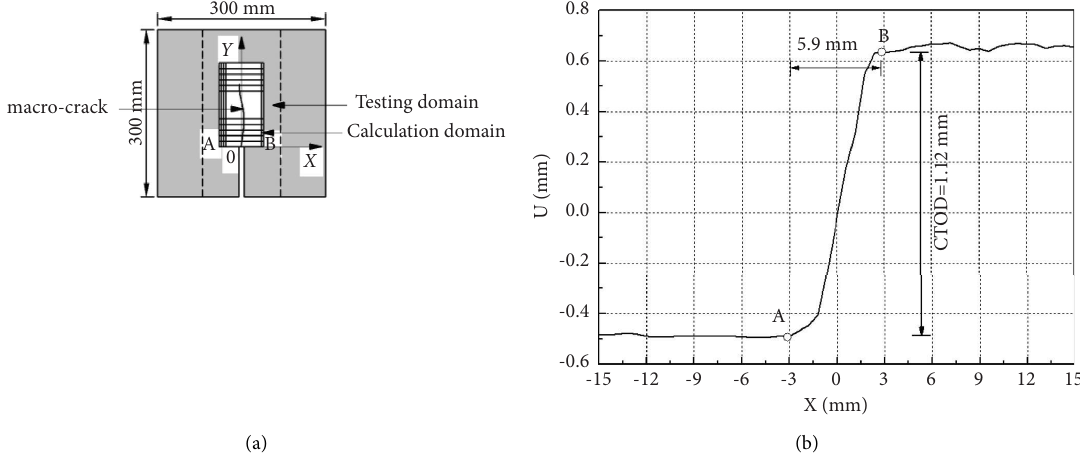
Figure 3: Diagram on the calculation method of crack opening displacement. (a) Testing zone. (b) Displacement along X